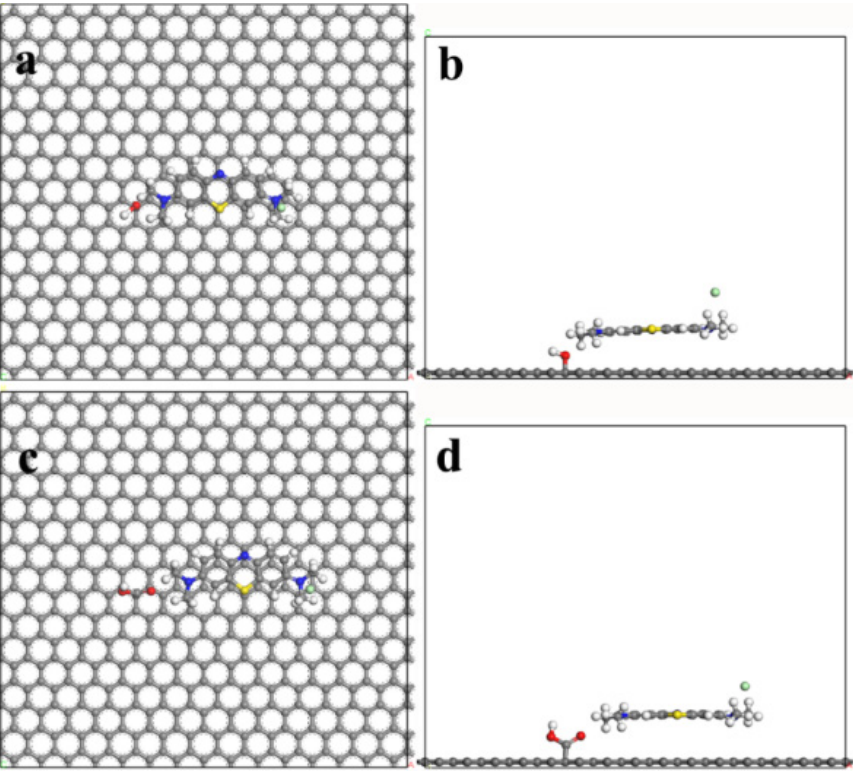
Figure 5. Model of hydroxyl and carboxyl groups. ( a ) Top view of hydroxyl group; ( b ) side view of hydroxyl group; ( c ) top view of carboxyl group; ( d ) side view of carboxyl group.